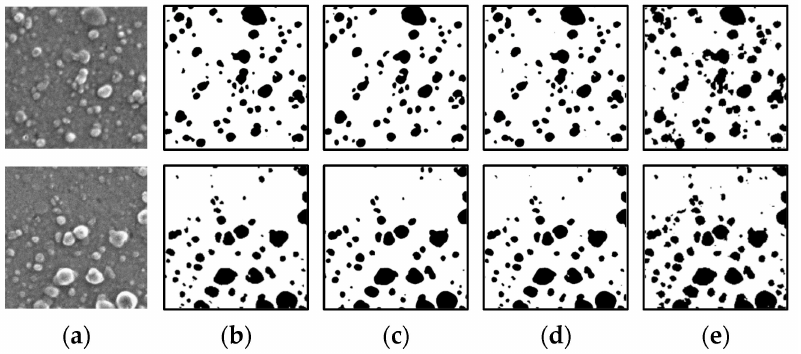
Figure 9. Results of image processing after segmentation (large number of particles). ( a ) Input data; ( b ) Output data (ground truth). Results obtained using ( c ) conventional U-Net; ( d ) U-Net #1; ( e ) U-Net